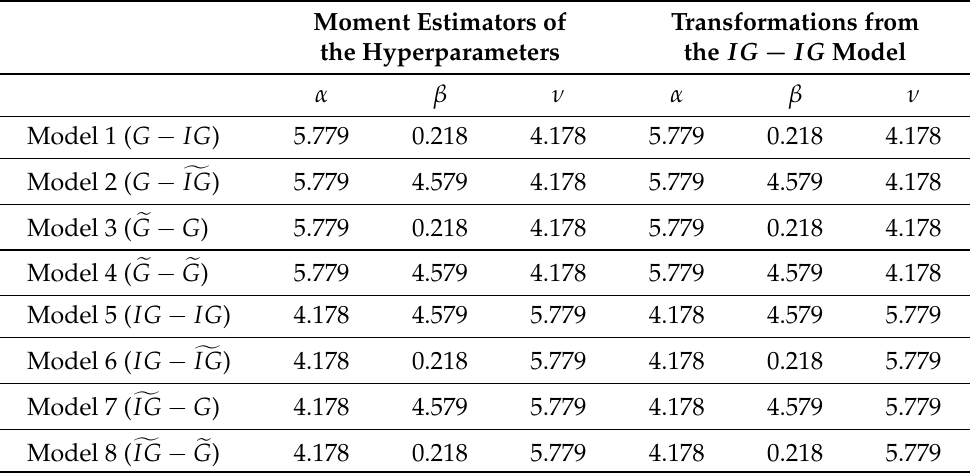
Table 2. The moment estimators of the hyperparameters of the 8 hierarchical models that have conjugate priors and the transformations of the moment estimators of the hyperparameters of the IG − IG